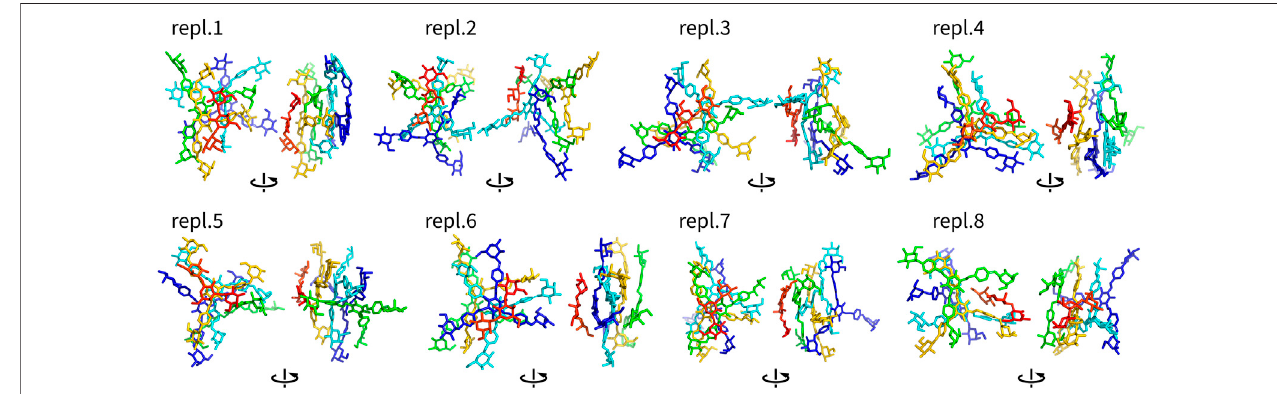
FIGURE5| AssembliesY4T(non-hydrogenatoms)after100 nsshownintwodifferentorientationsrotatedby90 ° .TheyarecoloredbyatomIDinthesystem(Yariv molecules are blue to orange, saccharides are in red).